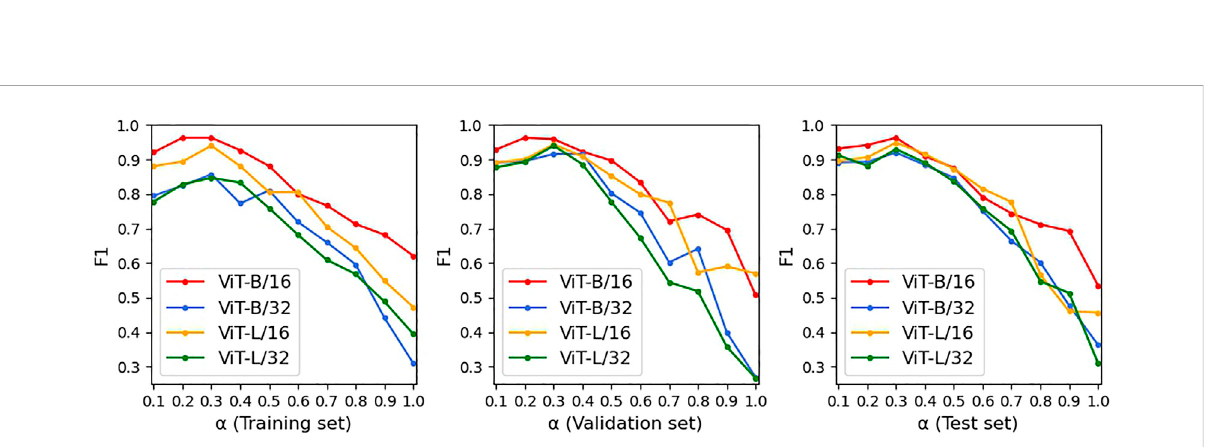
FIGURE 7 F1 score of link prediction on four different ViT structures, where red, blue, orange, and green refer to ViT-B/16, ViT-B/32, ViT-L/16, and ViT-L/ 32, respectively (set all blocks to six).